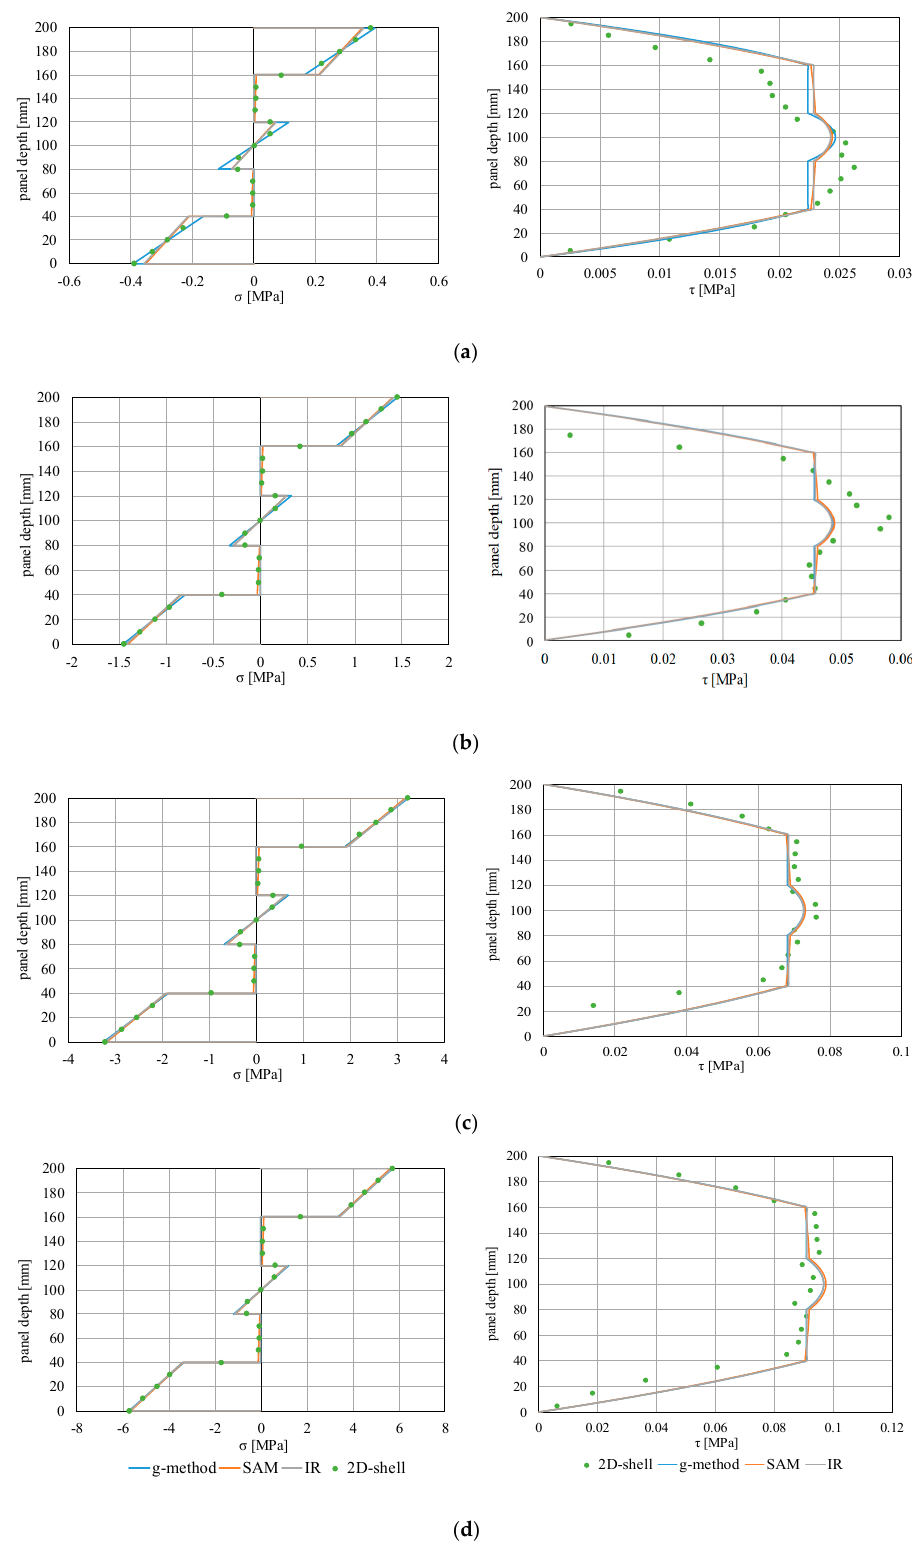
Figure 9. Normal and tangential stresses diagrams for different H/L ratios. ( a ) L/H=10; ( b ) L/H=20; ( c ) L/H=30; ( d ) L/H=40.